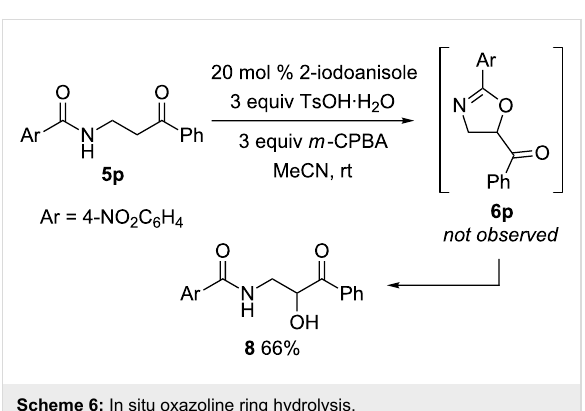
Scheme 6: In situ oxazoline ring